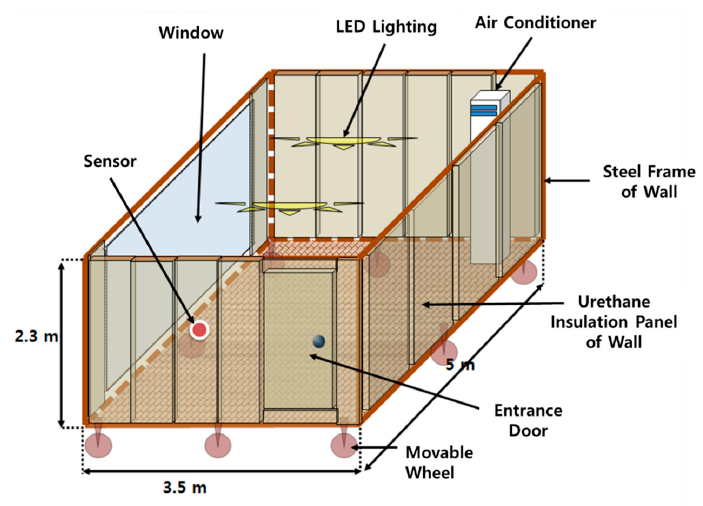
Figure 18. Size and configuration of inner chamber, location of air conditioner and sensor.